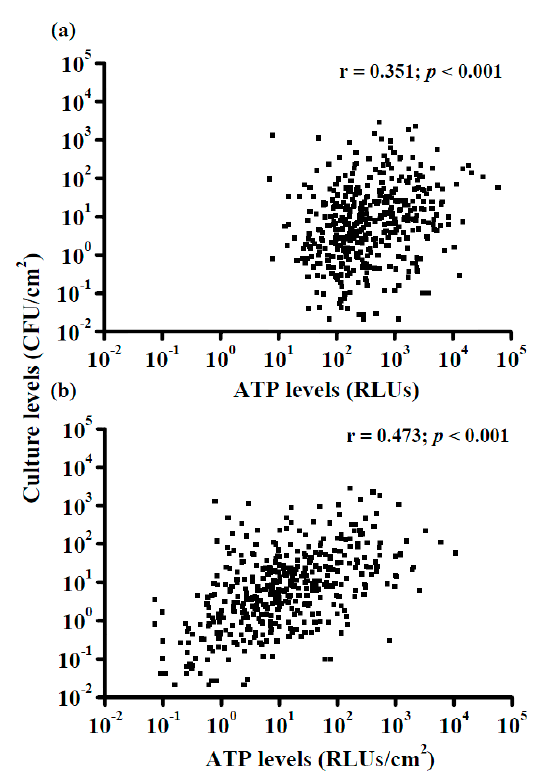
Figure 2. Correlation between the culture-based levels and either ( a ) the non-adjusted ATP-based (RLU) levels or ( b ) the adjusted ATP-based levels (RLU/cm 2 ) obtained from 11 sampling sites in 22 patient rooms.